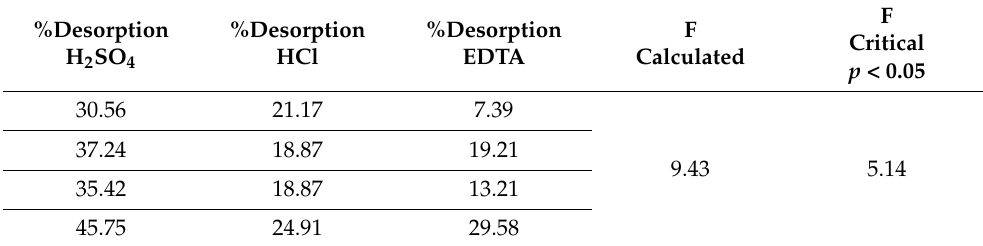
Table 4. Analysis of variance between extractant solutions for